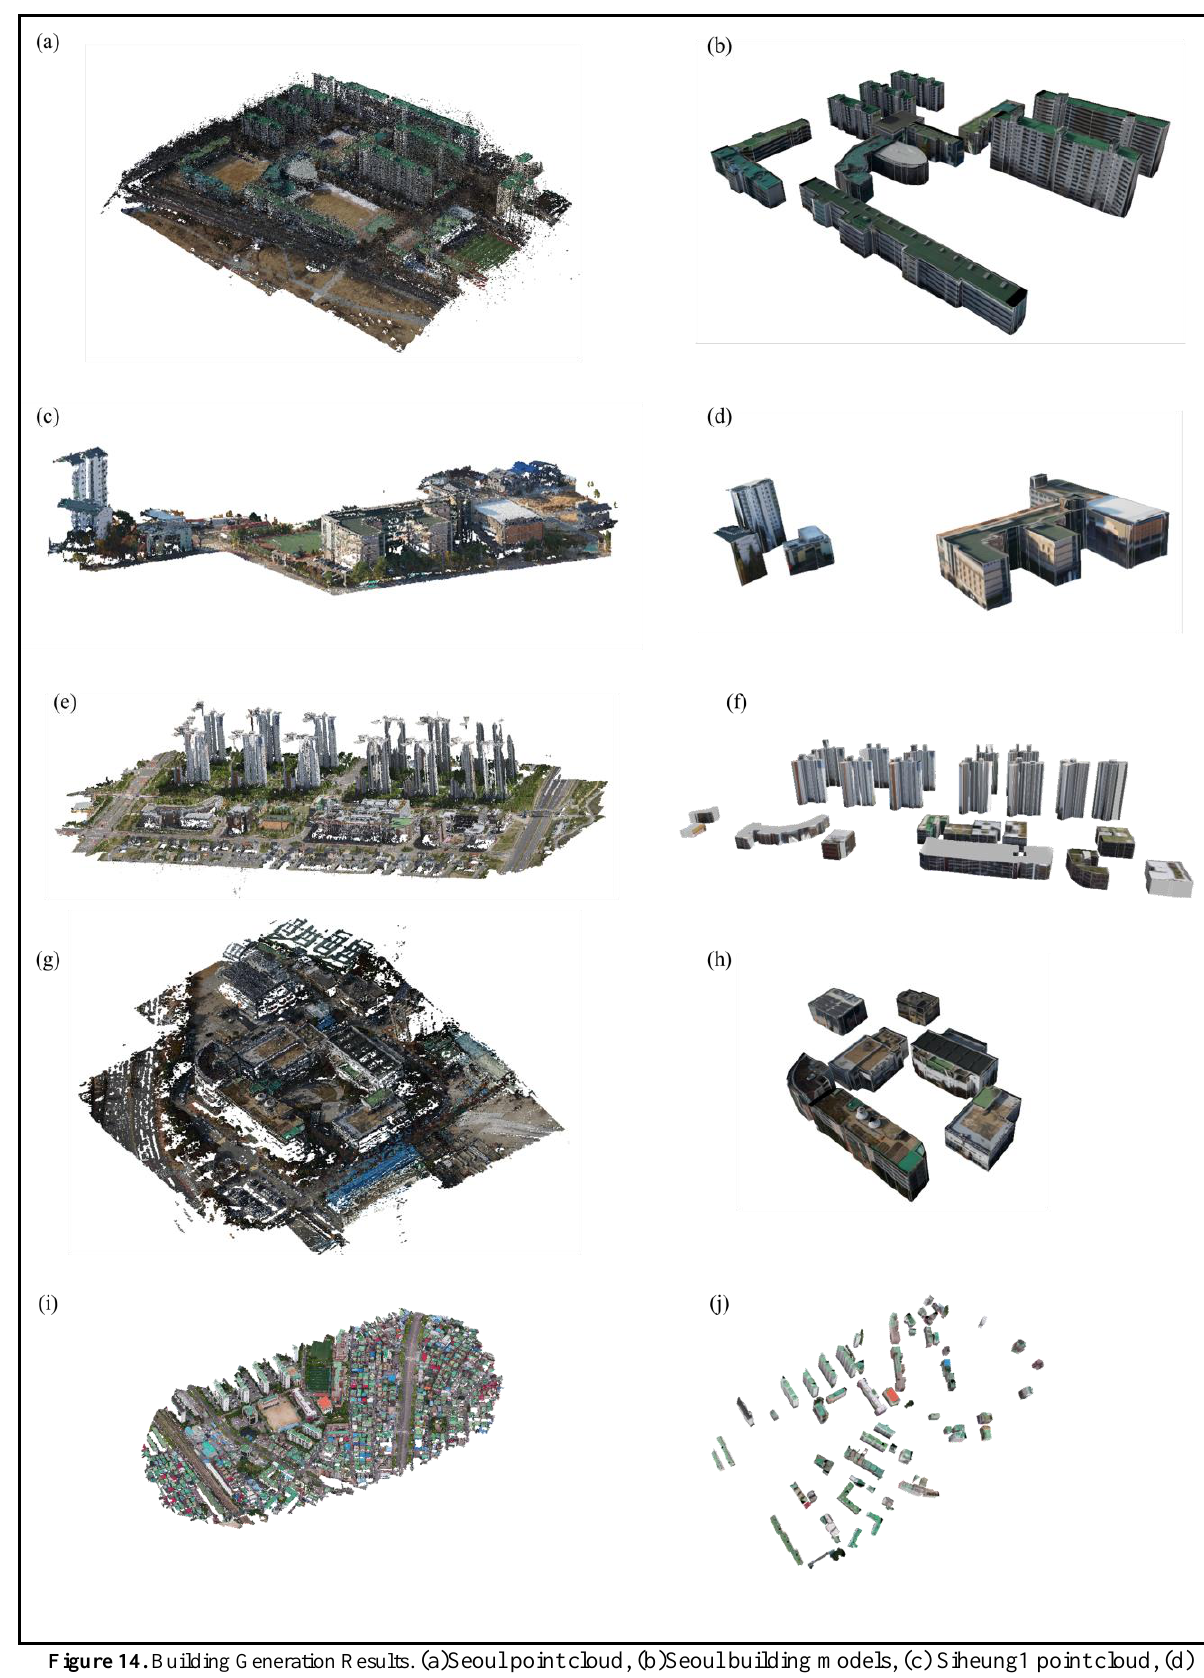
Figure 14. Building Generation Results. (a)Seoul point cloud, (b)Seoul building models, (c) Siheung1 point cloud, (d) Siheung1 building models, (e) Siheung2 point cloud, (f) Siheung2 building models, (g) Goyang point cloud, (h) Goyang building models, (i) Incheon point cloud, (j) Incheon building